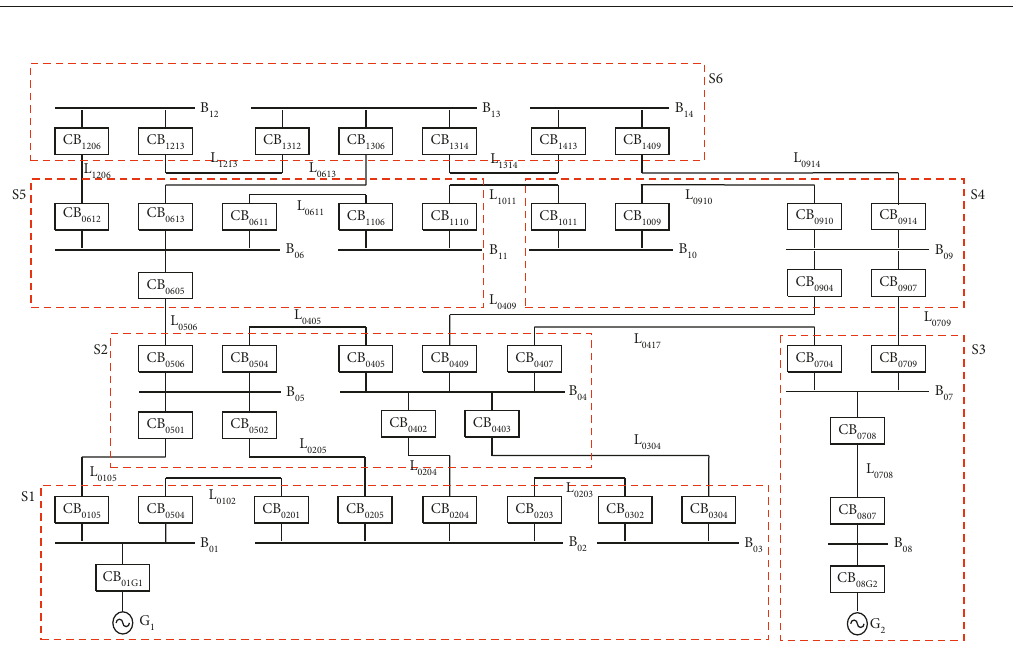
Figure 8: The partition result of the IEEE 14-bus system.